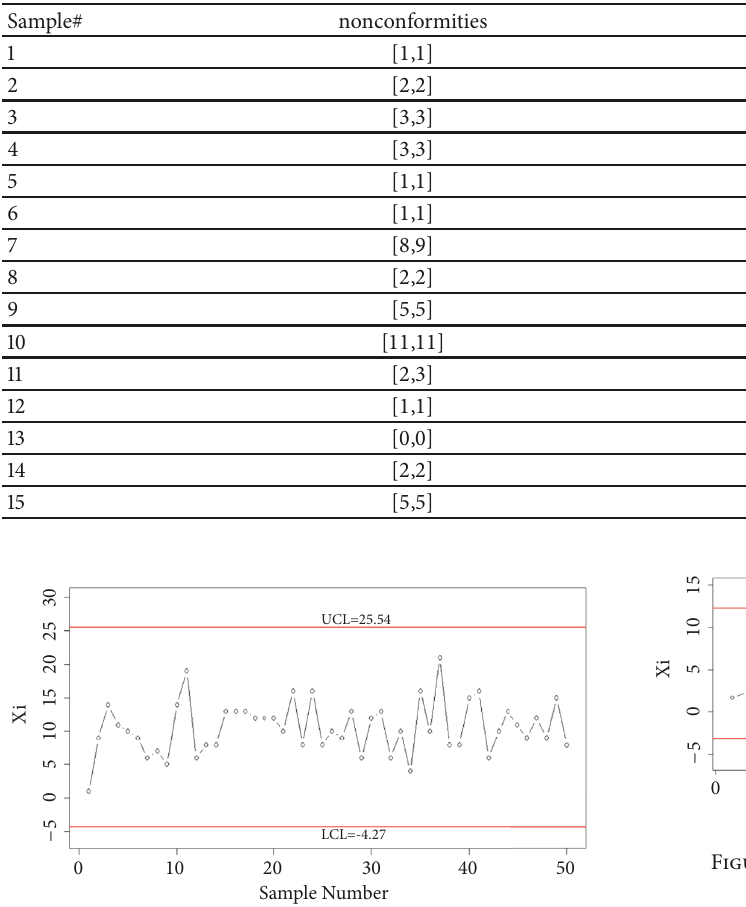
Figure 2: The exiting control chart for simulated data.